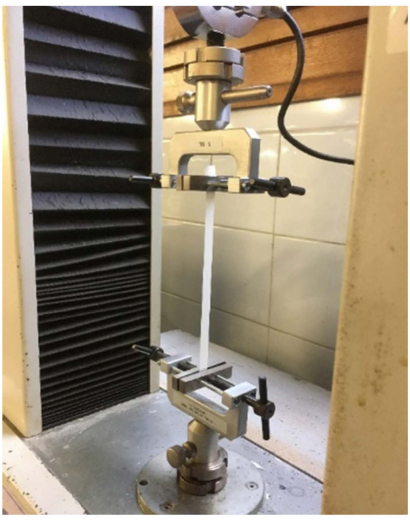
Figure 6. Tensile test setup.